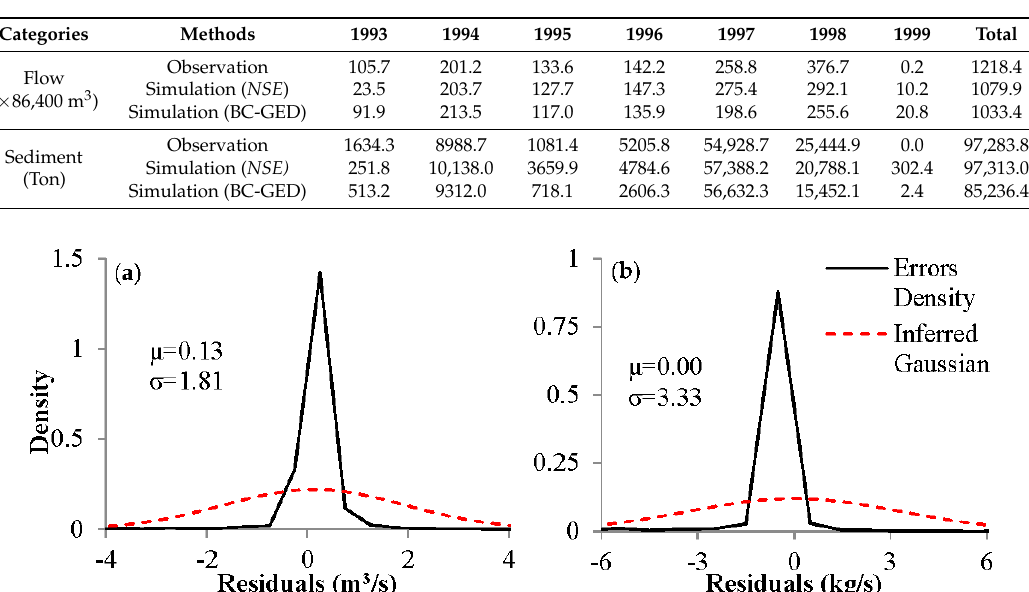
Table 3. Comparison of total flow and sediment amount between simulation and observation during flood season for each year.